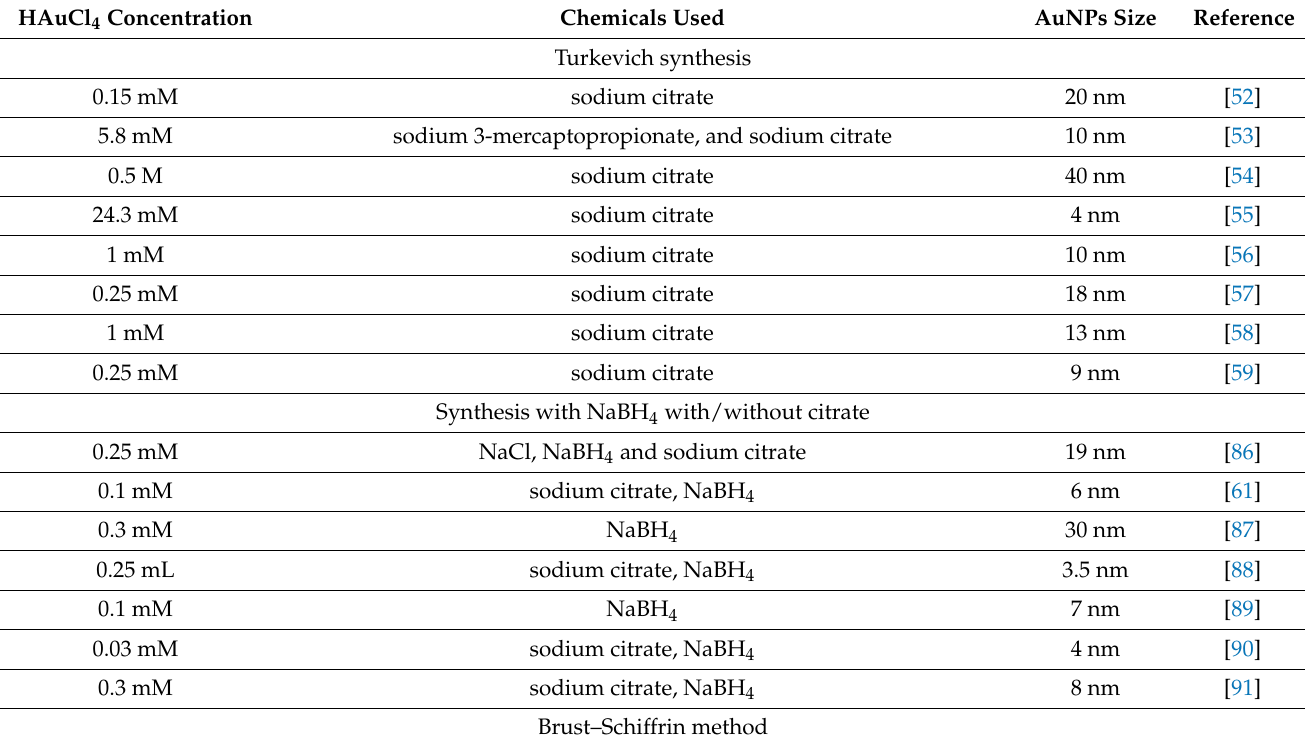
Table 1. Summary of the methods for AuNP